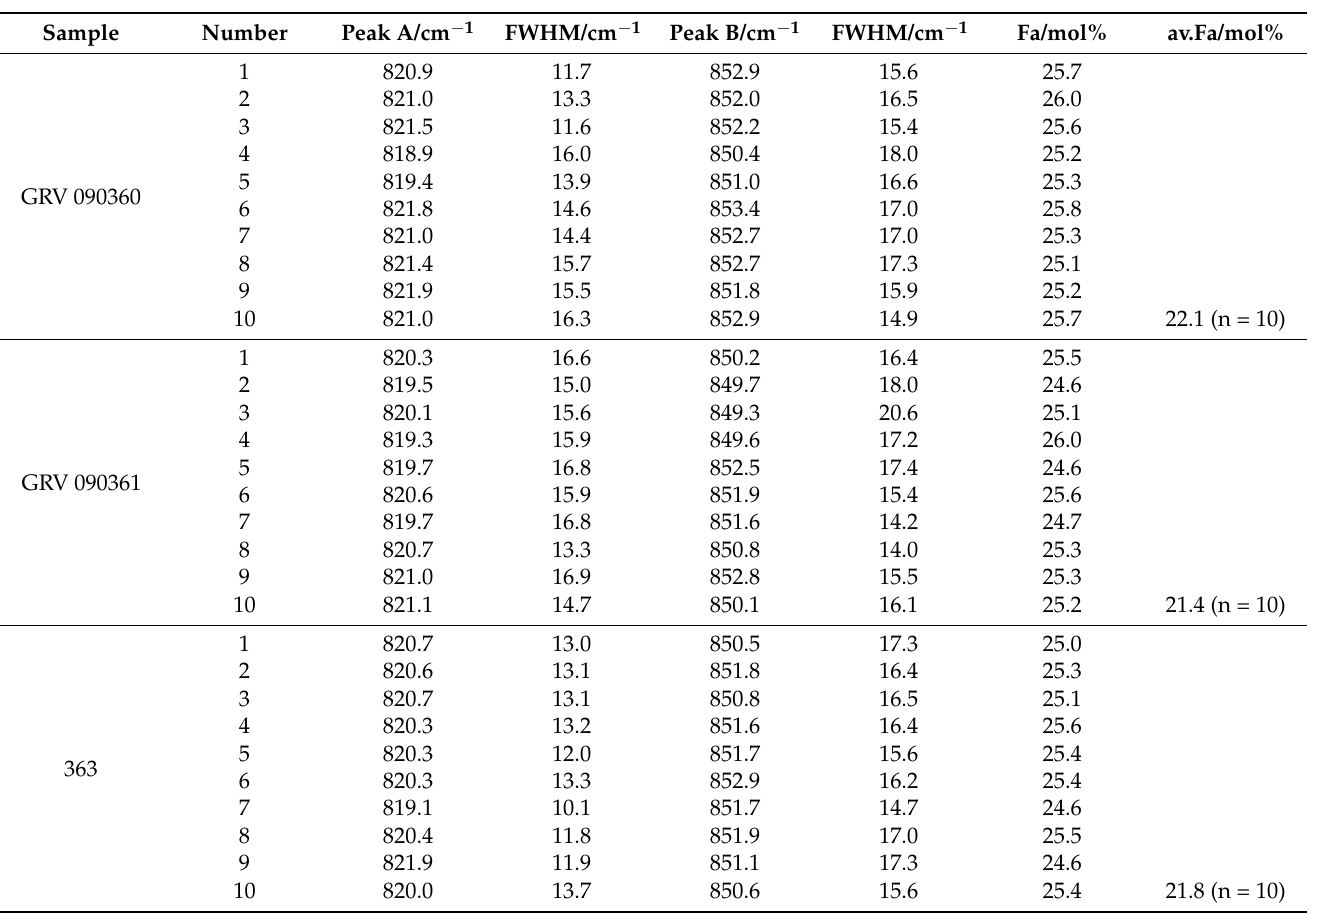
Table A1. The Raman spectrum and corresponding EPMA data of olivine in selected samples.